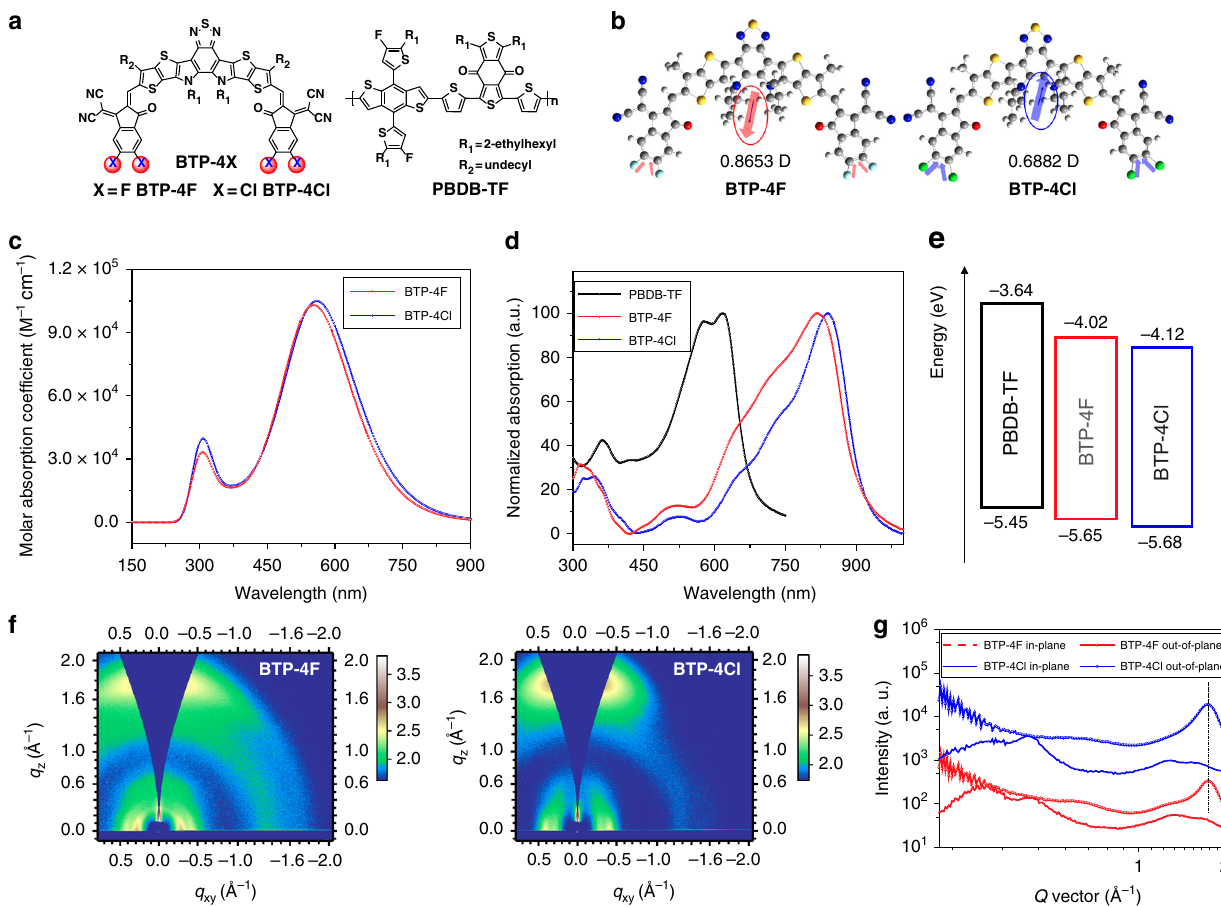
Fig. 1 Molecular structure, optical, and electrochemical properties. a Chemical structure of the BTP-4X acceptors and the polymer donor PBDB-TF. b Molecular dipoles in the optimized molecular models for the BTP-4X acceptors. c Calculated UV – Vis absorption spectra of the BTP-4X. d Normalized UV – vis absorption spectra of the donor and acceptors as thin fi lms. e Schematic energy level alignment of the materials measured by the SWV